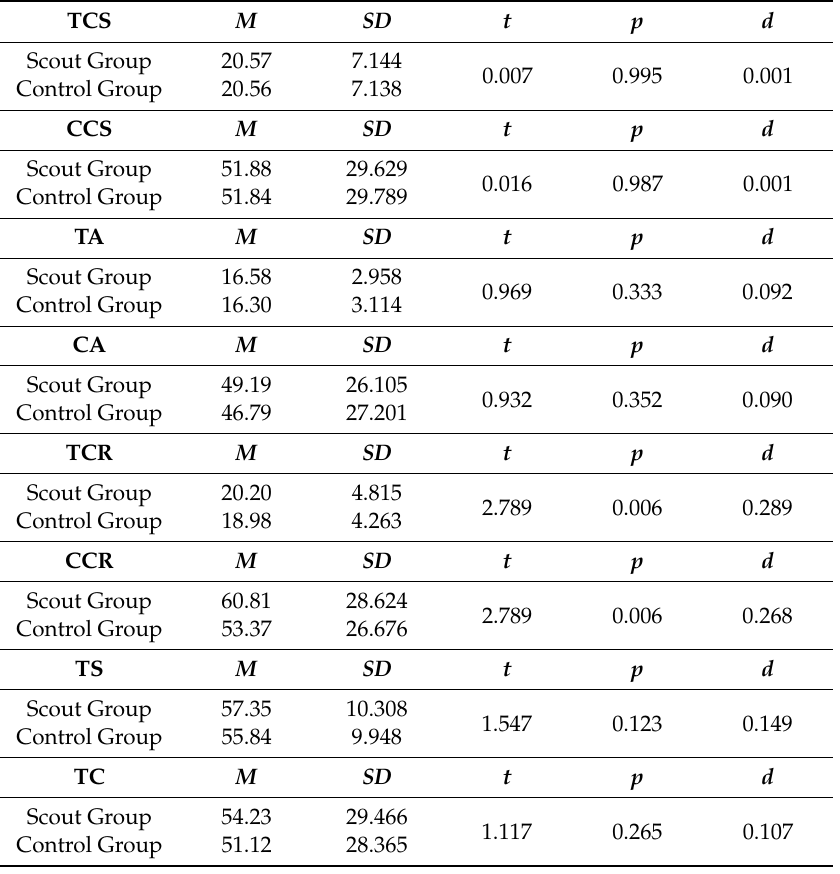
Table 4. t -test to contrast social skills between Scout and non-Scout